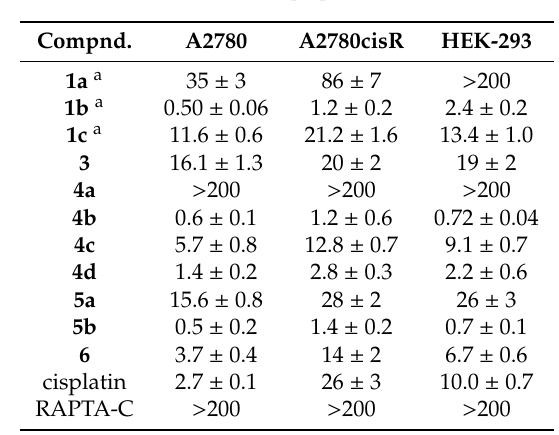
Table 3. IC 50 values ( µ M) determined for compounds 3 , 4a – d (and their vinyliminium precursors 1a – c ), 5a – b , 6 , cisplatin and RAPTA-C on human ovarian carcinoma (A2780), human ovarian carcinoma cisplatin resistant (A2780CisR) and human embryonic kidney (HEK-293) cell lines after 72 h exposure. Values are given as the mean ± SD. a See reference